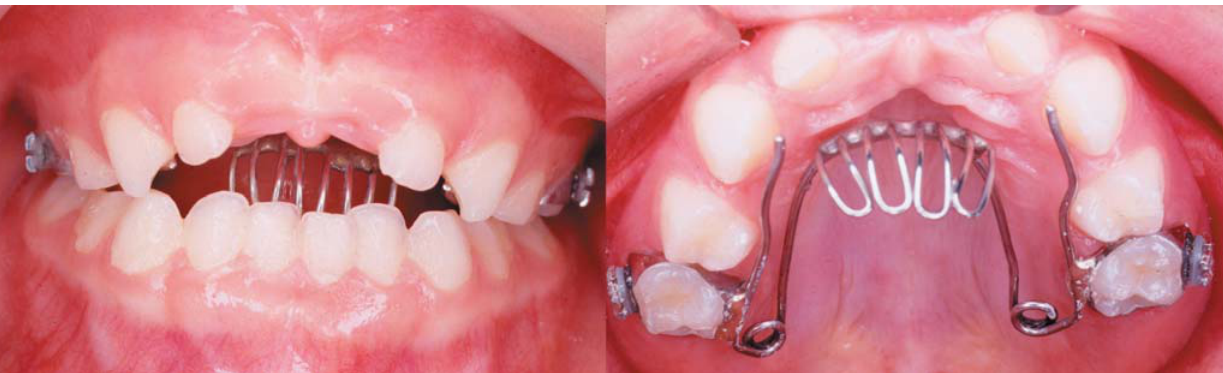
FIGURE 3- Frontal and occlusal views immediately after the placement of a fixed palatal crib soldered on the bi-helix